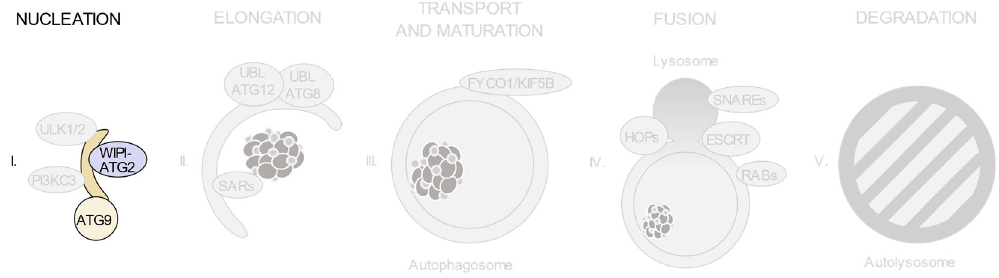
Figure 5. The phosphatidylinositol 3-phosphate (PI(3)P)-binding proteins (WIPI or ATG2 proteins) and ATG9-containing vesicles participate in the nucleation of the pre-autophagosomal membrane. To date, only one pathogenic SNP on DFCP1 has been found, which is linked to tuberculosis